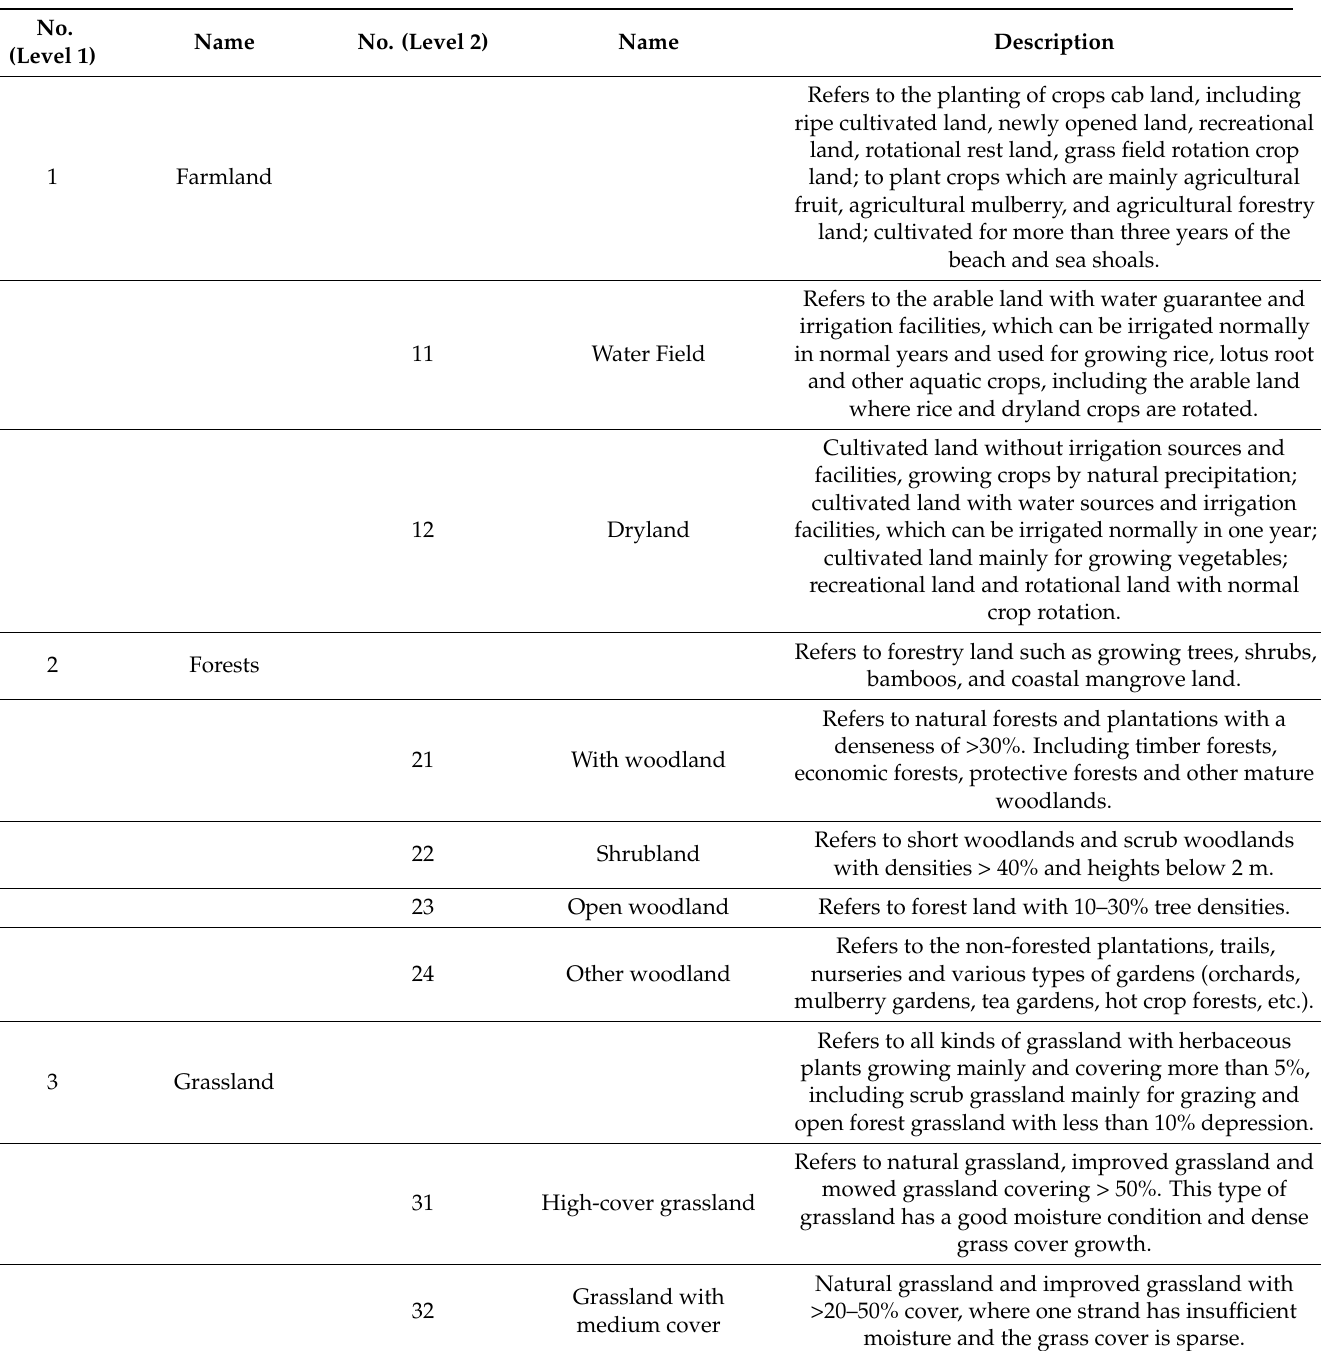
Table A1. Chinese Academy of Sciences secondary land use classification